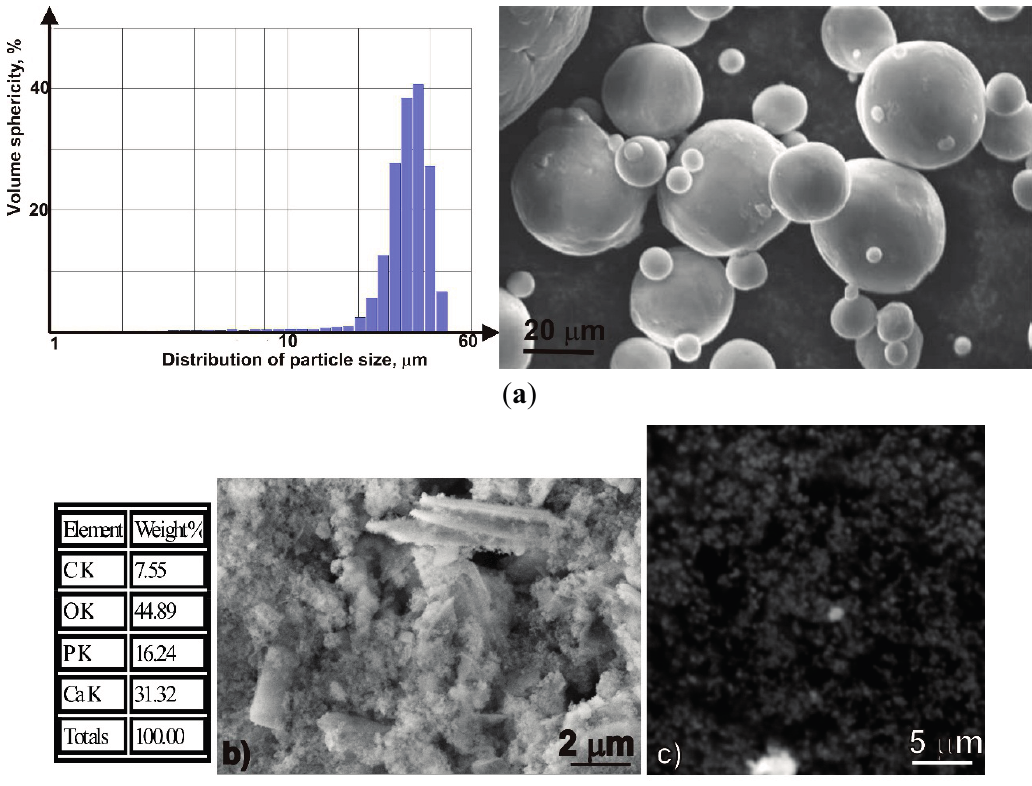
Figure 1. SEM images of initial TiGd2 and HA powders under larger magnification: ( a ) TiGd2 image and its granulometric distribution; ( b ) HA of sub micron size from Medicoat Co. (Mägenwil, Switzerland) with EDX analysis; and ( c ) HA of nano size from EvNanoTech.com Ltd. (Hefei,